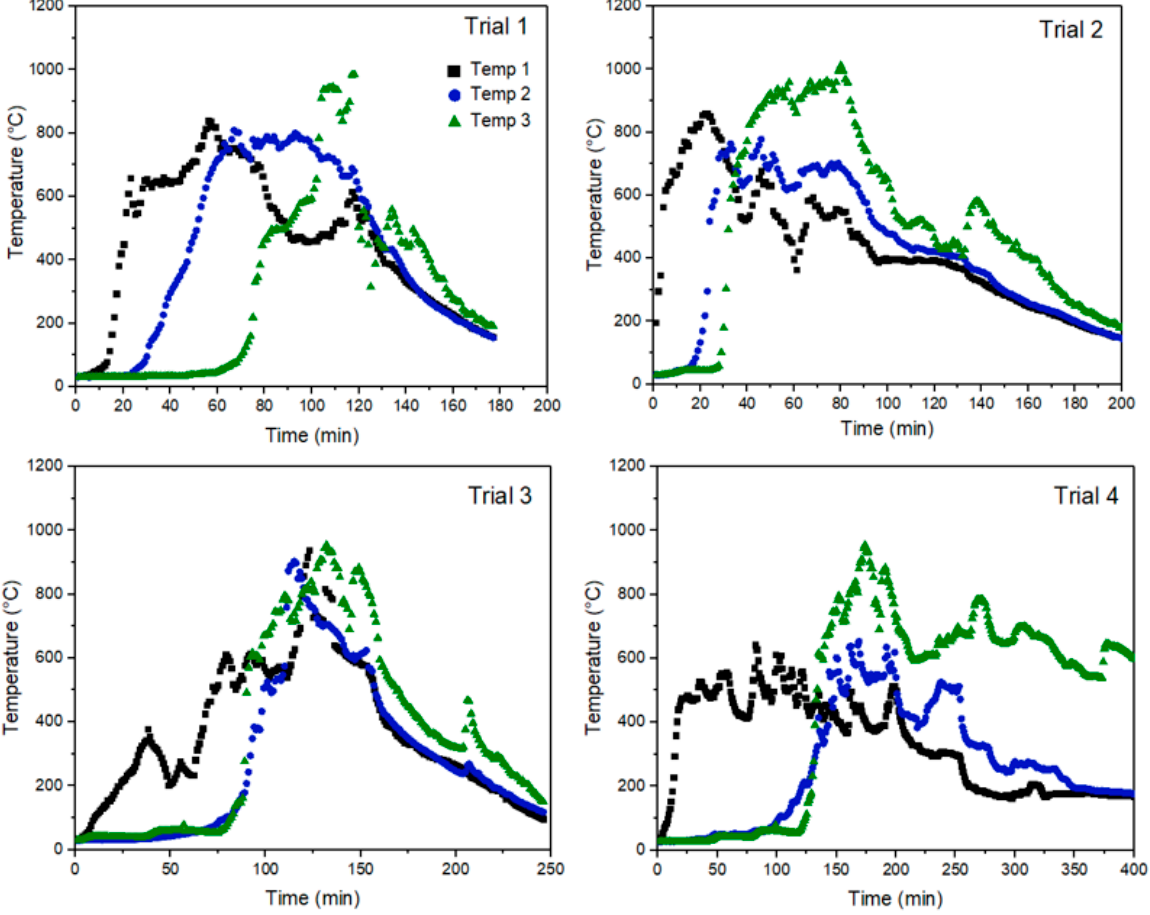
Figure 6. Temperature profiles for the three thermocouples placed in the dual-chamber pyrolizer at different trials.